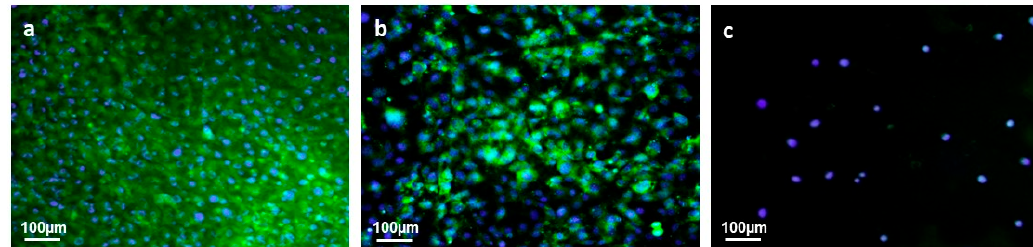
Table 3. Results of cell count after 1 day and 7 days of culturing. Sample